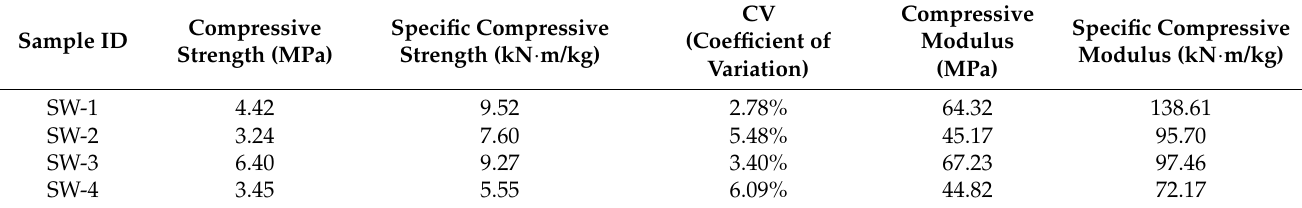
Table 3. Compressive properties of sandwich composites.